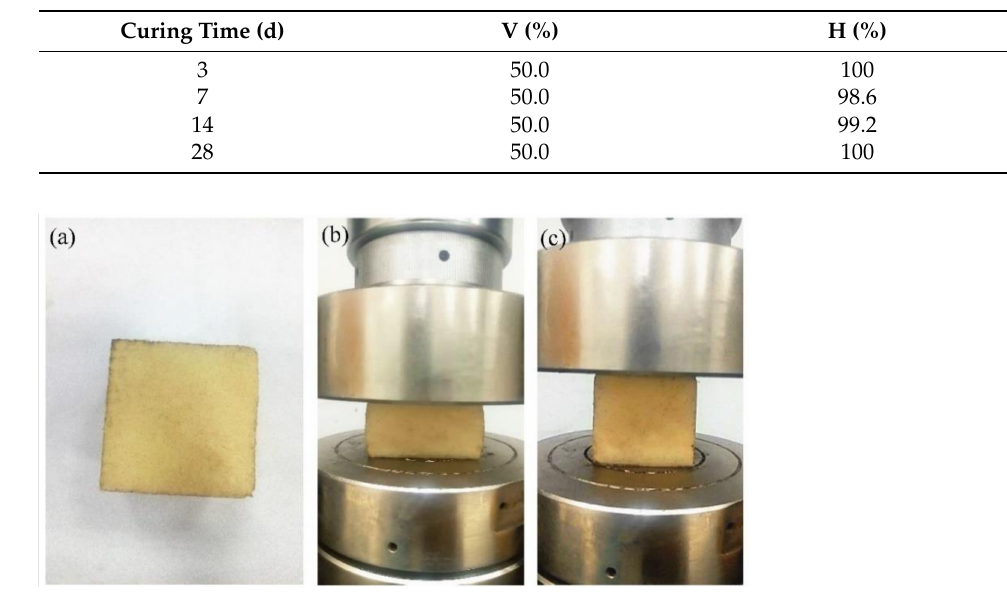
Table 4. Deformation recovery of resin system under 50% compressive deformation.